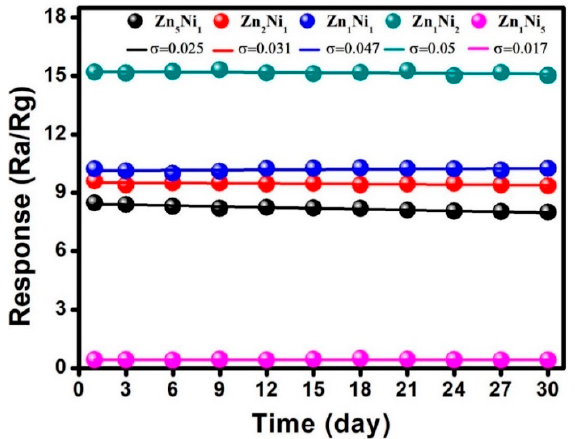
Figure 11. Long-term stability of as-prepared 3D n -ZnO / p -NiO based sensors toward 50 ppm NH 3 at 280 °C .